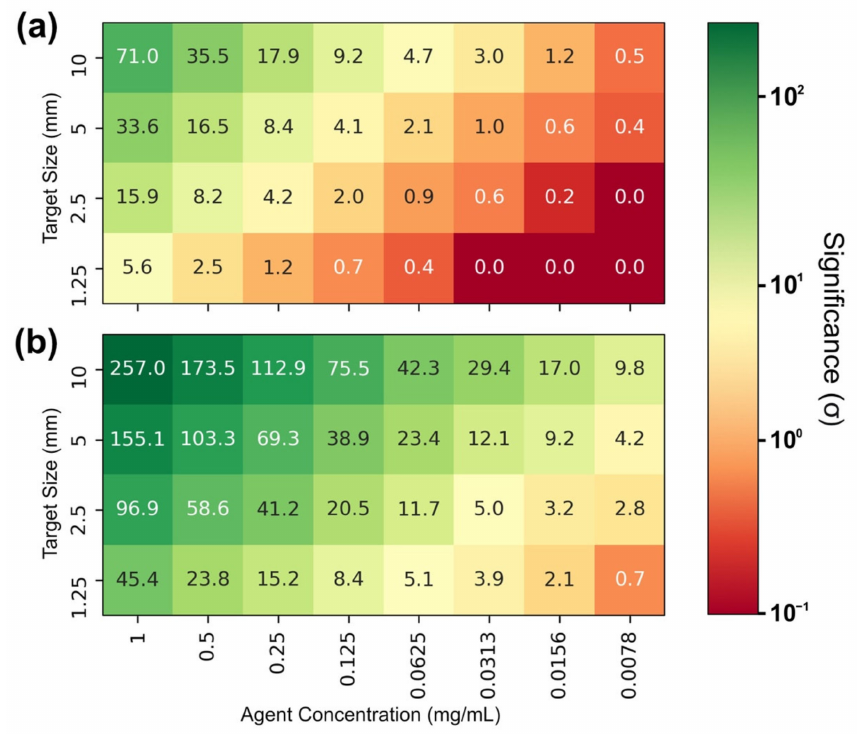
Figure 4. Significance Z at varying agent concentration and target size with Au-fluorescence ( a ) and Pd-fluorescence ( b ).